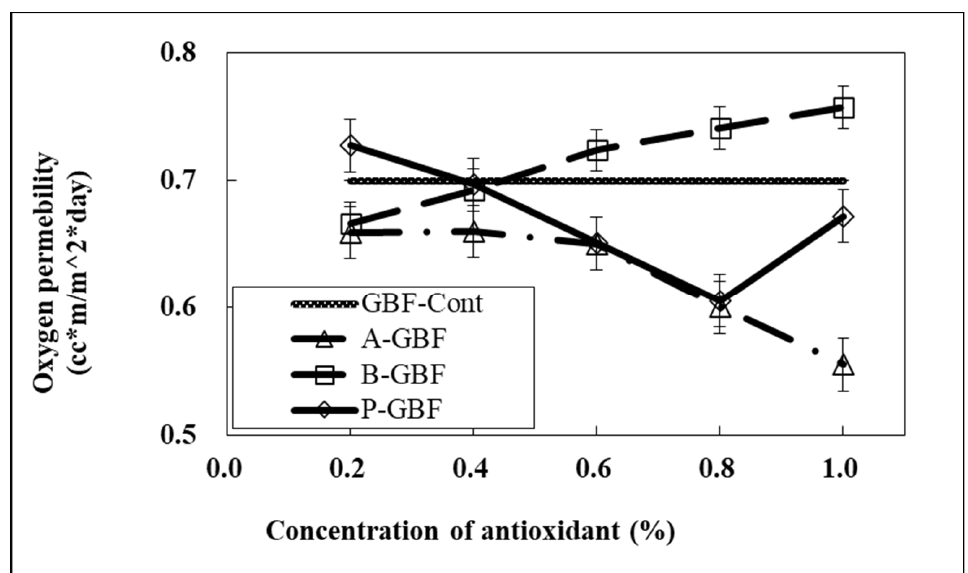
Figure 3. Oxygen permeability of GBFs incorporating antioxidants at various concentrations (50% RH, 23 °C). Note that GBF-Cont represents pure GBF while A-, B-, and P- stand for ascorbic acid, BHA, and phytic acid, respectively. Bars indicate the standard deviation.